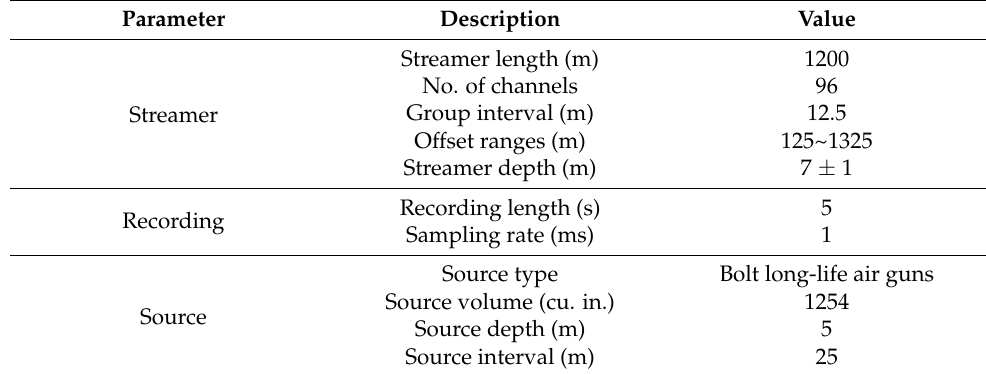
Table 1. Seismic data acquisition